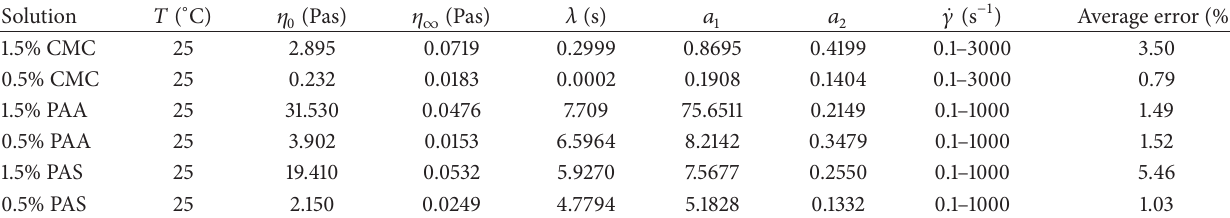
Table 1: Parameters of the Carreau-Yasuda viscosity model for the studied solutions.